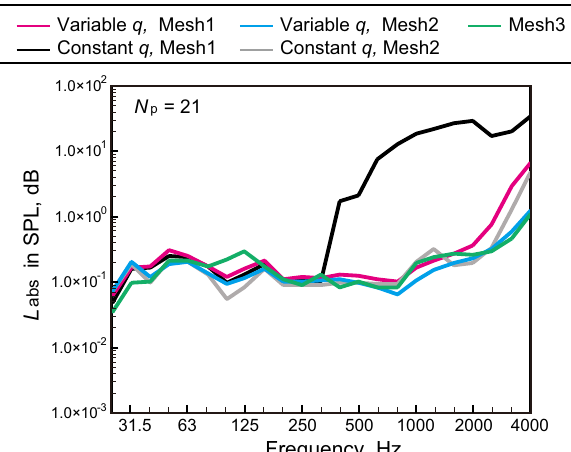
Figure 6. A comparison of the absolute errors using the Variable q -approach and the Constant q